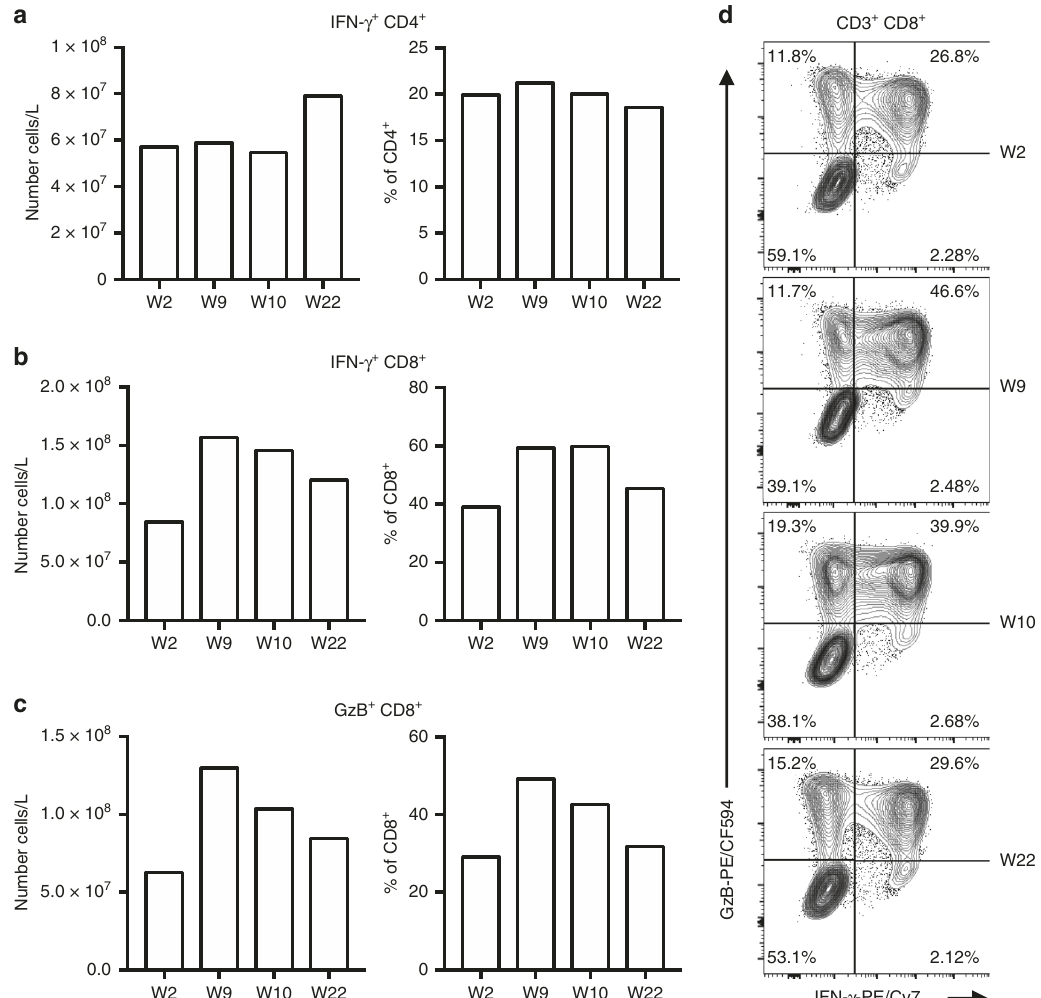
Fig. 3 Peripheral IFN- γ -producing T cells remain elevated under ICI-mTORi combination therapy. PBMC were stimulated with phorbol 12-myristate 13- acetate (PMA) and ionomycin and treated with GolgiStop (monensin solution) for 4 h before intracellular fl ow cytometric staining of various cytokines. a , b The number and proportions of IFN- γ + ( a ) CD4 + and ( b ) CD8 + T cells are shown. c The number and concentration of granzyme B (GzB)-producing CD8 + T cells in peripheral blood are shown. d Sample fl ow cytometry plots of CD8 + T cell cytokine production are provided. Flow cytometric analyses were completed